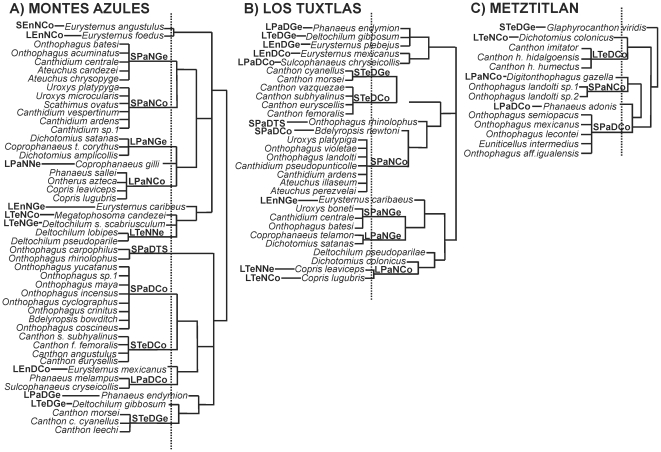
Dendrogram of the species forming functional groups.Functional groups were considered at an arbitrary Euclidian distance of
1.5 (dotted line). The branch length of these dendrograms was used to
analyze dung beetle functional diversity (FD) in (A) the Montes Azules
Biosphere Reserve, (B) the Los Tuxtlas Biosphere Reserve, and (C) the
Barranca de Metztitlán Biosphere Reserve. The names of the
functional groups are combinations of the following characteristics:
S = small, L = Large,
Pa = paracoprid,
En = endocoprid,
Te = telecoprid, D = diurnal,
N = nocturnal,
Ge = generalist,
Co = coprophage,
Ne = necrophage, and
TS = trophic specialist.